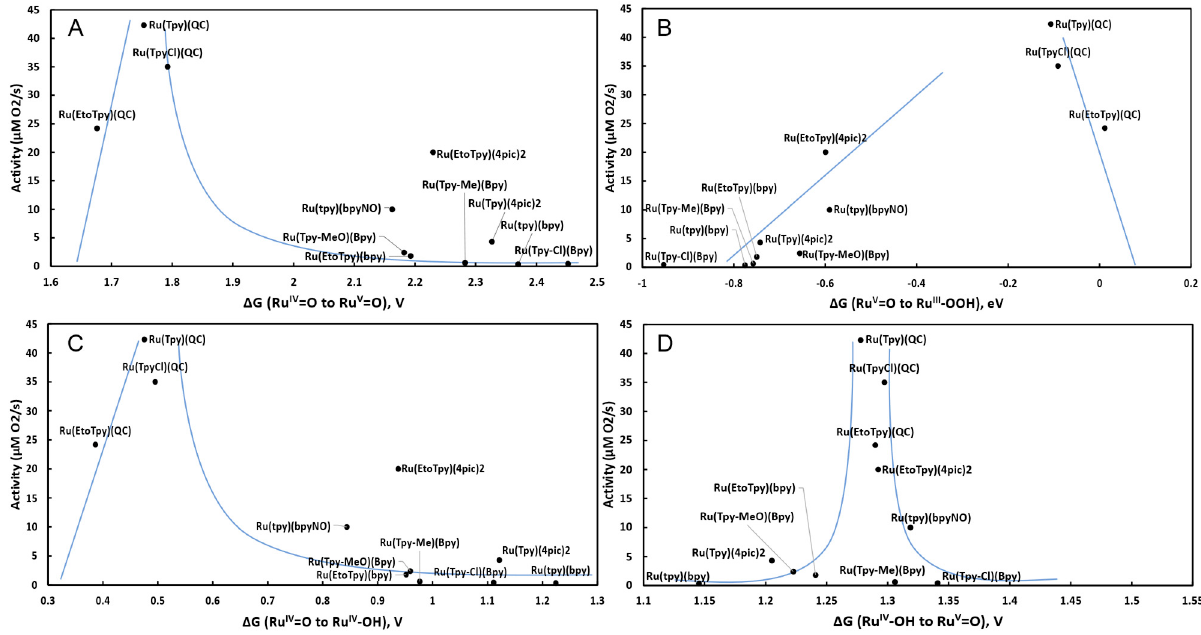
Figure 4. Plots of activity over computed ( A ) potential of conventional Ru IV = O to Ru V = O ET redox reaction, ( B ) change in free energy of WNA on Ru V = O, ( C ) change in free energy of the Ru IV = O to Ru IV − OH protonation reaction, and ( D ) redox potential of the PCET Ru IV −− OH to Ru V = O reaction. Bda − type catalysts are omitted due to their 2nd − order dependence on catalyst